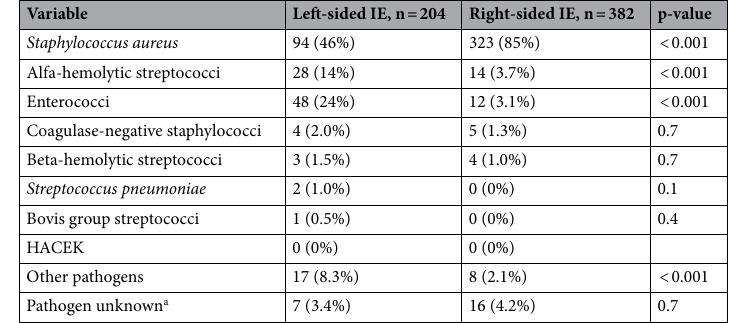
Table 2. Microbiological aetiology in IVDUs. S. aureus includes both methicillin-sensitive (n = 411, 98.5%) and methicillin-resistant (n = 6, 1.5%). Alpha-hemolytic streptococci includes digestive, oral and unclassified alpha-hemolytic streptococci. Enterococci includes Enterococcus faecium , Enterococcus faecalis and unclassified enterococcal species. Beta-hemolytic streptococci includes group A, B, C, F, and G. Other pathogens include other gram-positive and gram-negative bacteria and fungi. HACEK, Haemophilus species , Aggregatibacter actinomycetemcomitans, Cardiobacterium hominis, Eikenella corrodens, Kingella kingae ; IE infective endocarditis. a Pathogen unknown include patients without positive blood cultures and those where a pathogen was not identified with other means such as tissue culture or PCR of a valve specimen.